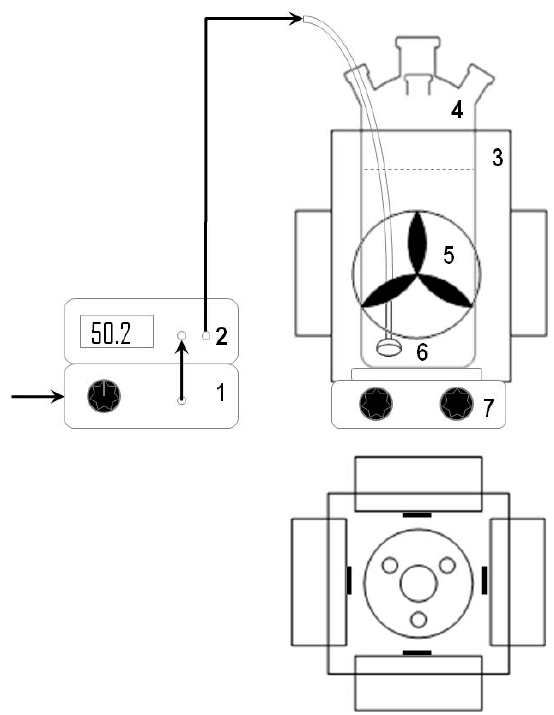
Figure 6. Scheme of the experimental set-up. 1: ozone generator, 2: ozone analyzer, 3: box of LEDs; 4: 4: glass reactor, 5: fan, 6: ceramic di ff user, and 7: magnetic glass reactor, 5: fan, 6: ceramic diffuser, and 7: magnetic stirrer.